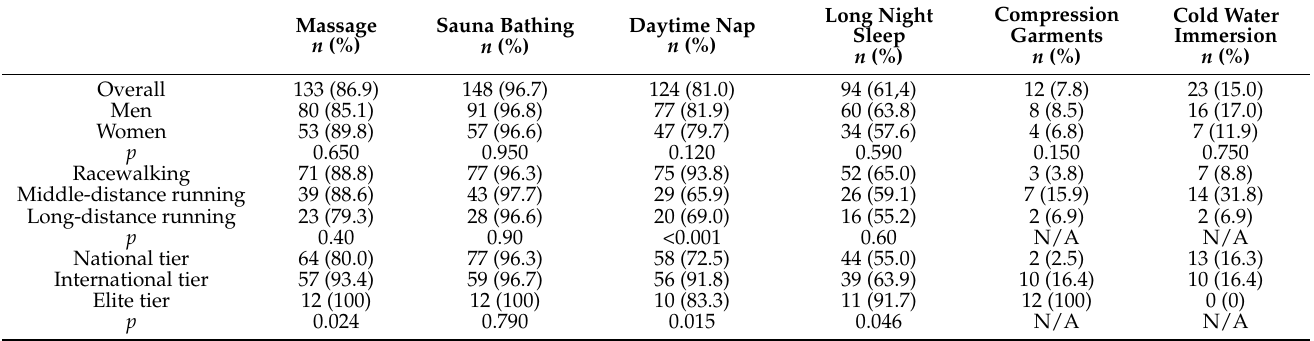
Table 6. Frequency of use of various methods of